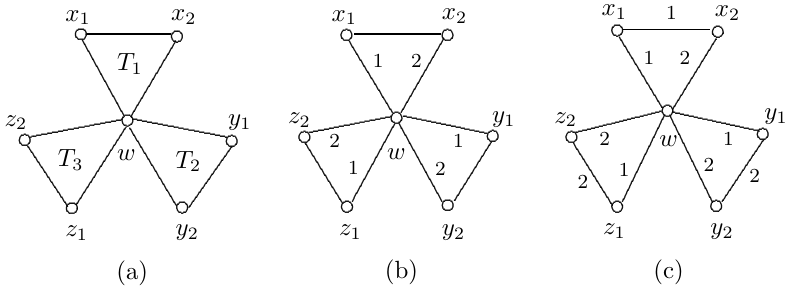
Figure 2: The friendship graph of order